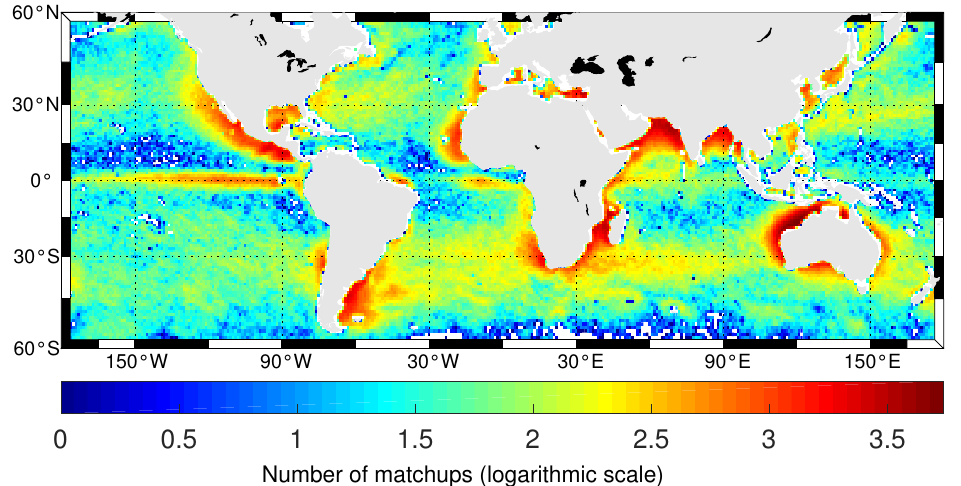
Figure 4. Number of collocations. The distribution of collocations is a combination of where the MODIS and AMSR-E data are both present, and this is reflected by the higher number of collocations in clear sky